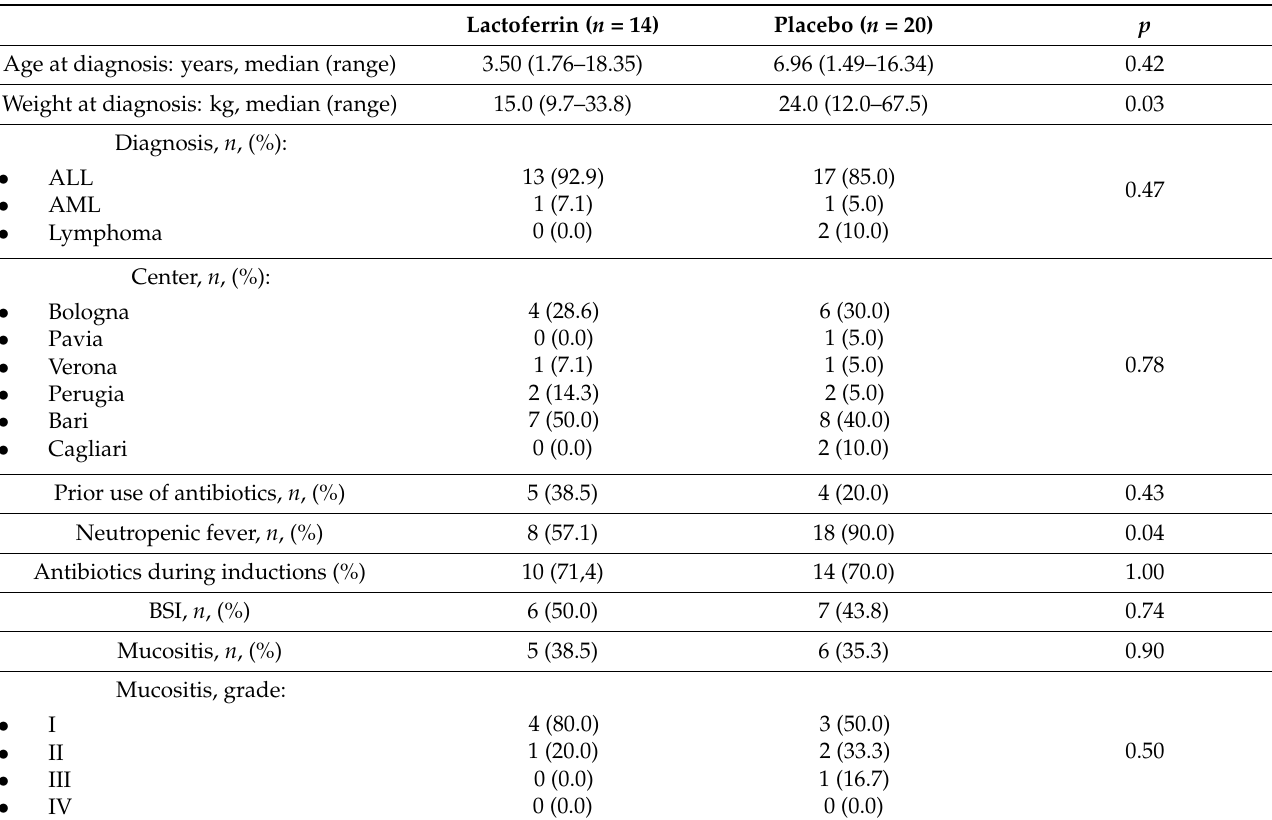
Table 1. Summary of patient characteristics in the two